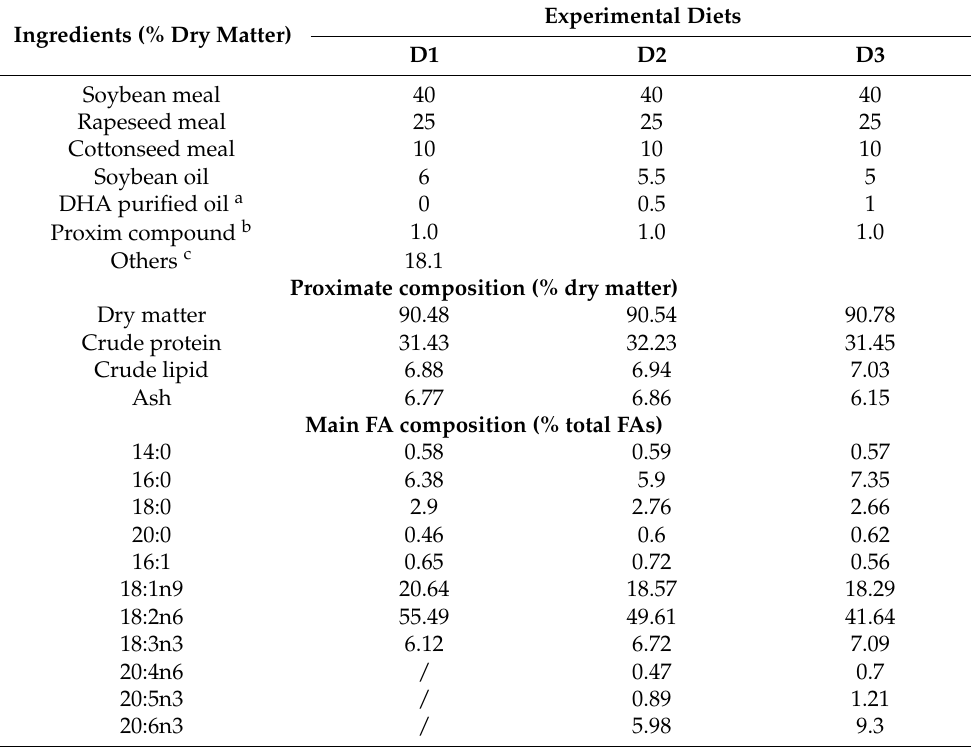
Table 1. Ingredients, proximate composition, and FA composition of